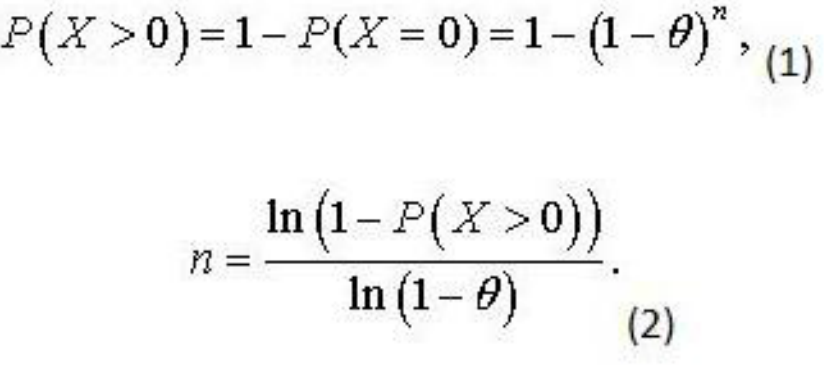
Figure 3. Equation (1, rearranged in 2) for determining the probability of detecting at least one file containing personal health